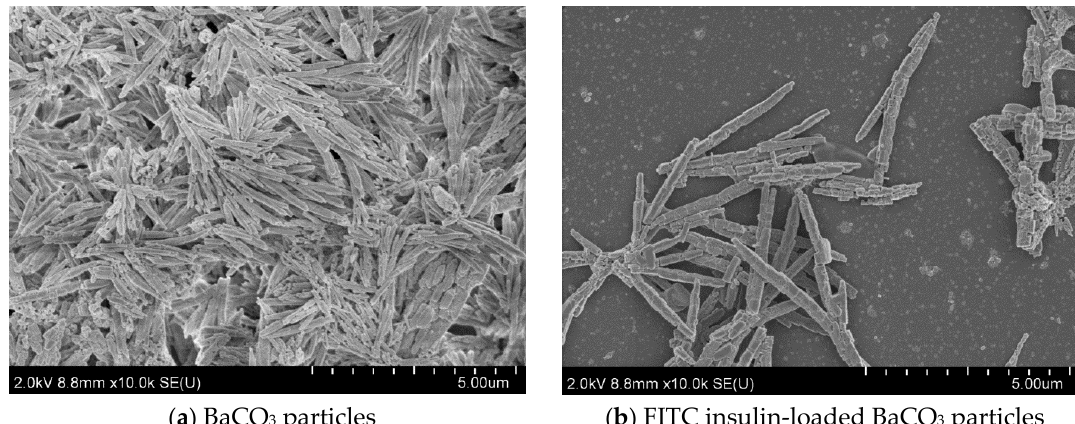
Figure 10. Images from free and insulin-loaded BaCO 3 particles. ( a ) Empty BaCO 3 particles look more aggregated. ( b ) Insulin-loaded BaCO 3 s form distinctive rod / needle-shaped separate clusters. Pictures were taken at 2.0 kV.